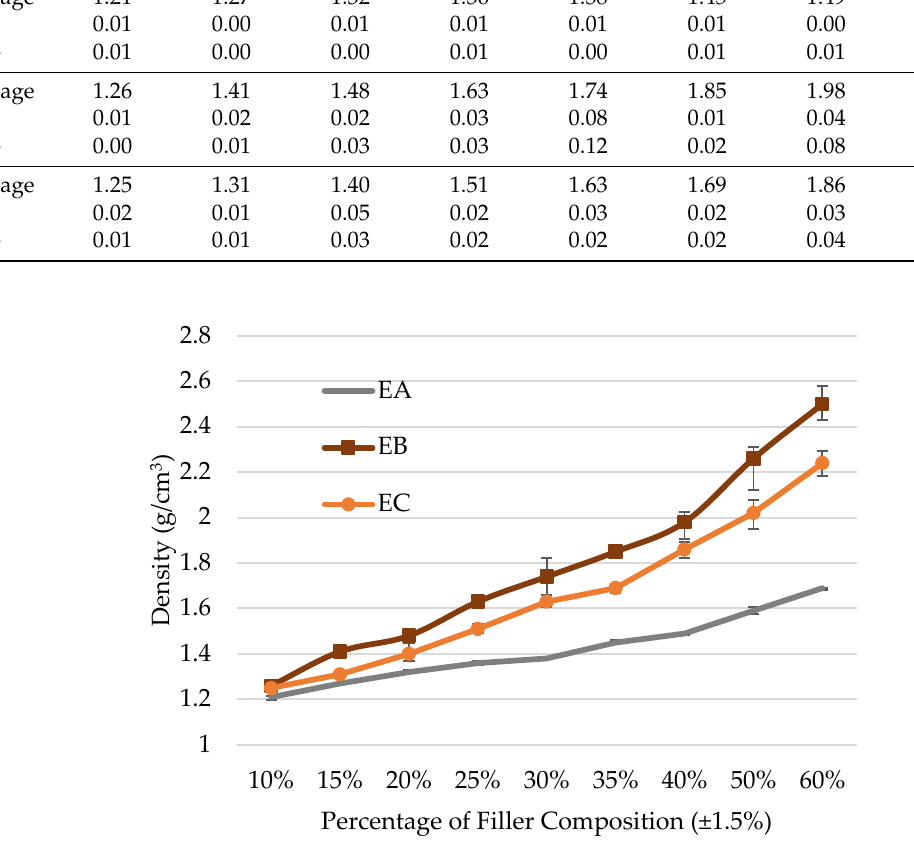
Figure 12. Effects of fillers on Density.